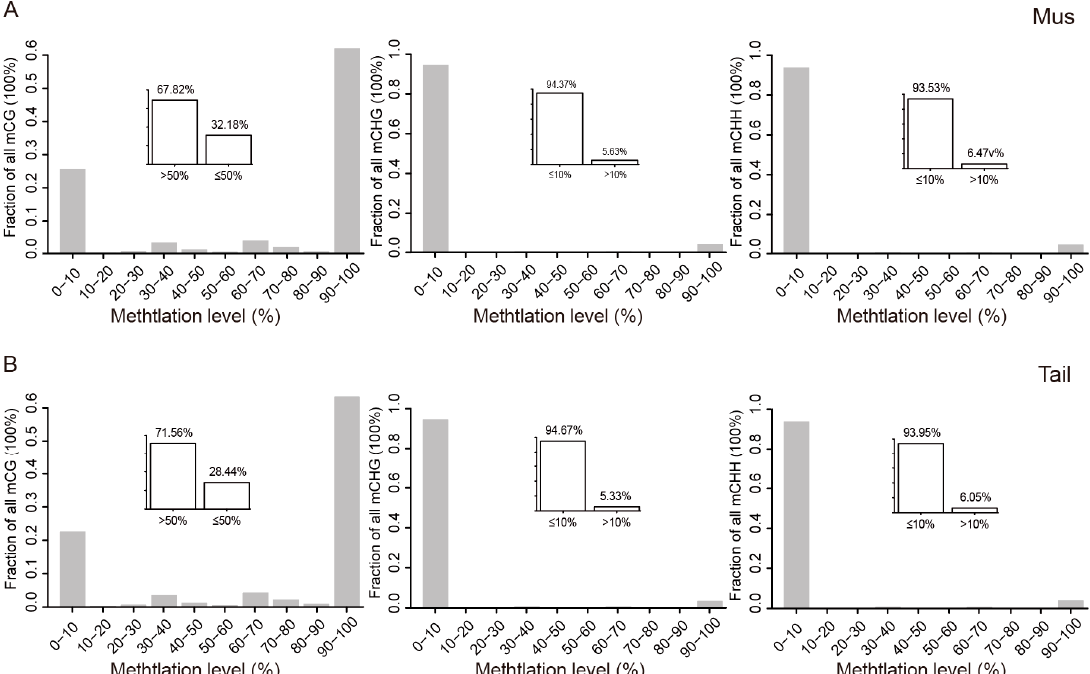
Figure 1. Global DNA methylation patterns. ( A ) Muscle tissue and ( B ) tail-fat tissue of DairyMeade sheep and Mongolian sheep, distribution of DNA methylation under CG, CHH and CHG contexts, only cytosines covered at least 3 times were considered.